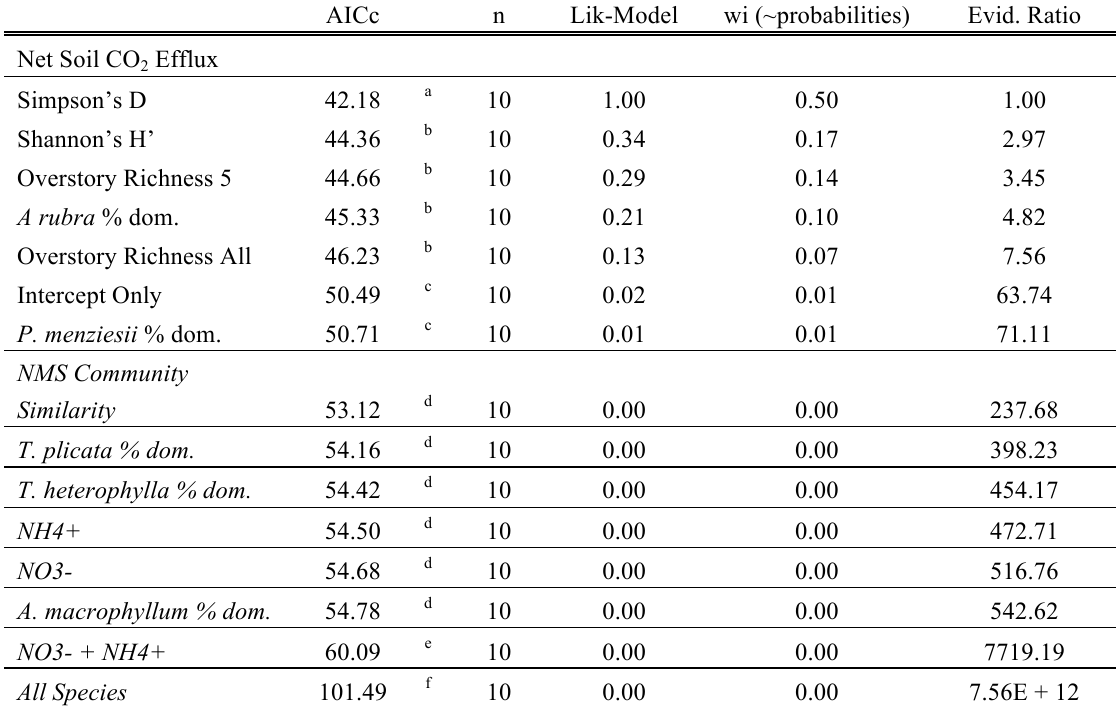
Table 5. Model selection ranking * for the best models predicting net soil CO plots where N data were also